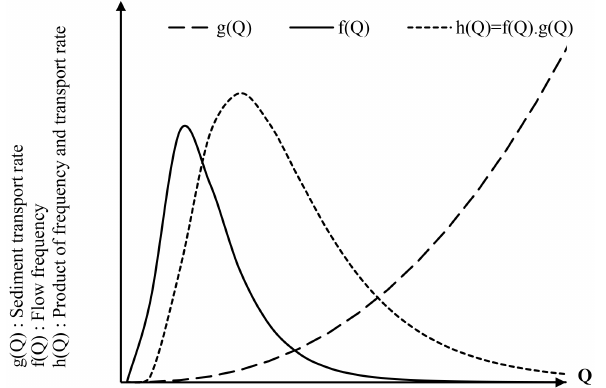
Figure 1. Effective discharge